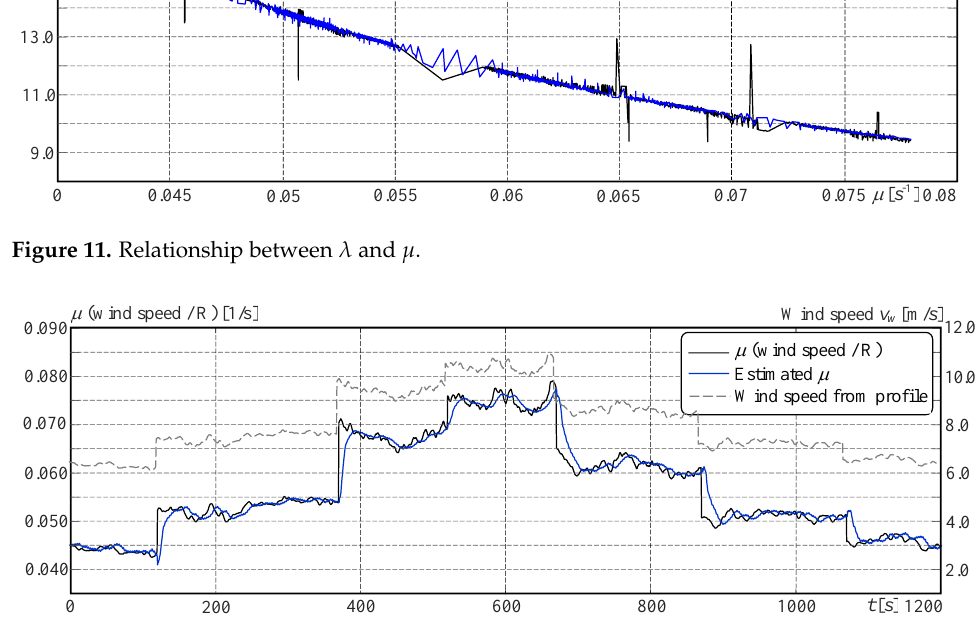
Figure 12. Time series of variable s.